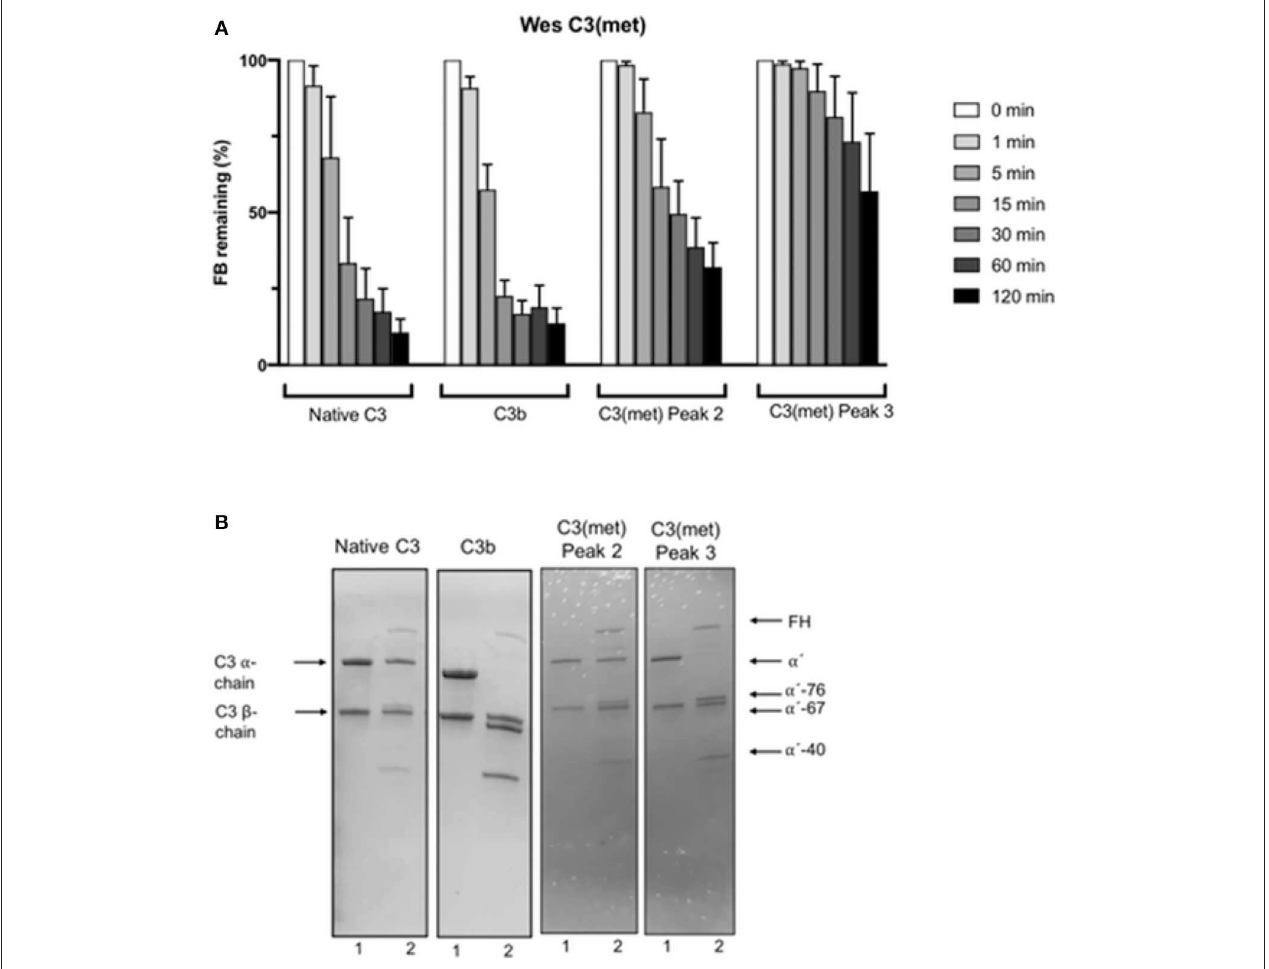
FIGURE 4 | (A) Wes immunoassay monitoring the consumption of FB due to cleavage to Bb and Ba after the addition of FD to native C3, C3b and peak 2 and 3 isolated after separation of methylamine treated C3 on a MonoS chromatography column at different time points from 1 to 120min. The decrease in FB due to cleavage to Bb and Ba was measured by Wes immunoassay using a specific mAb for Bb. The data is presented as mean ± SEM. (B) Cleavage by Factor I in the presence of Factor H of native C3, C3b and peak 2 and 3 isolated after separation of methylamine treated C3 on a MonoS chromatography analyzed by SDS-PAGE under reducing conditions. The samples before incubation are marked with “1” and the same samples after incubation with Factor I and Factor H are marked with “2” below each lane in the